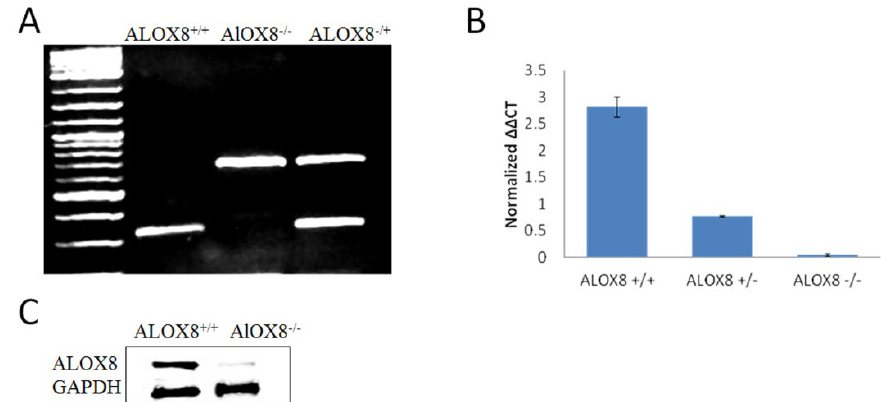
Figure 1. Characterization of ALOX8 − / − mice. All data shown are from uninfected mice. ( A ) Representative genotyping of ALOX8 +/+ , ALOX8 − / − and ALOX8 − / − mice. ( B ) qPCR analysis of ALOX8 mRNA levels in the lung of ALOX8 +/+ , ALOX8 +/ − and ALOX8 − / − mice. ( C ) Western blot analysis of ALOX8 protein levels in the lung of ALOX8 +/+ and ALOX8 − / − mice.